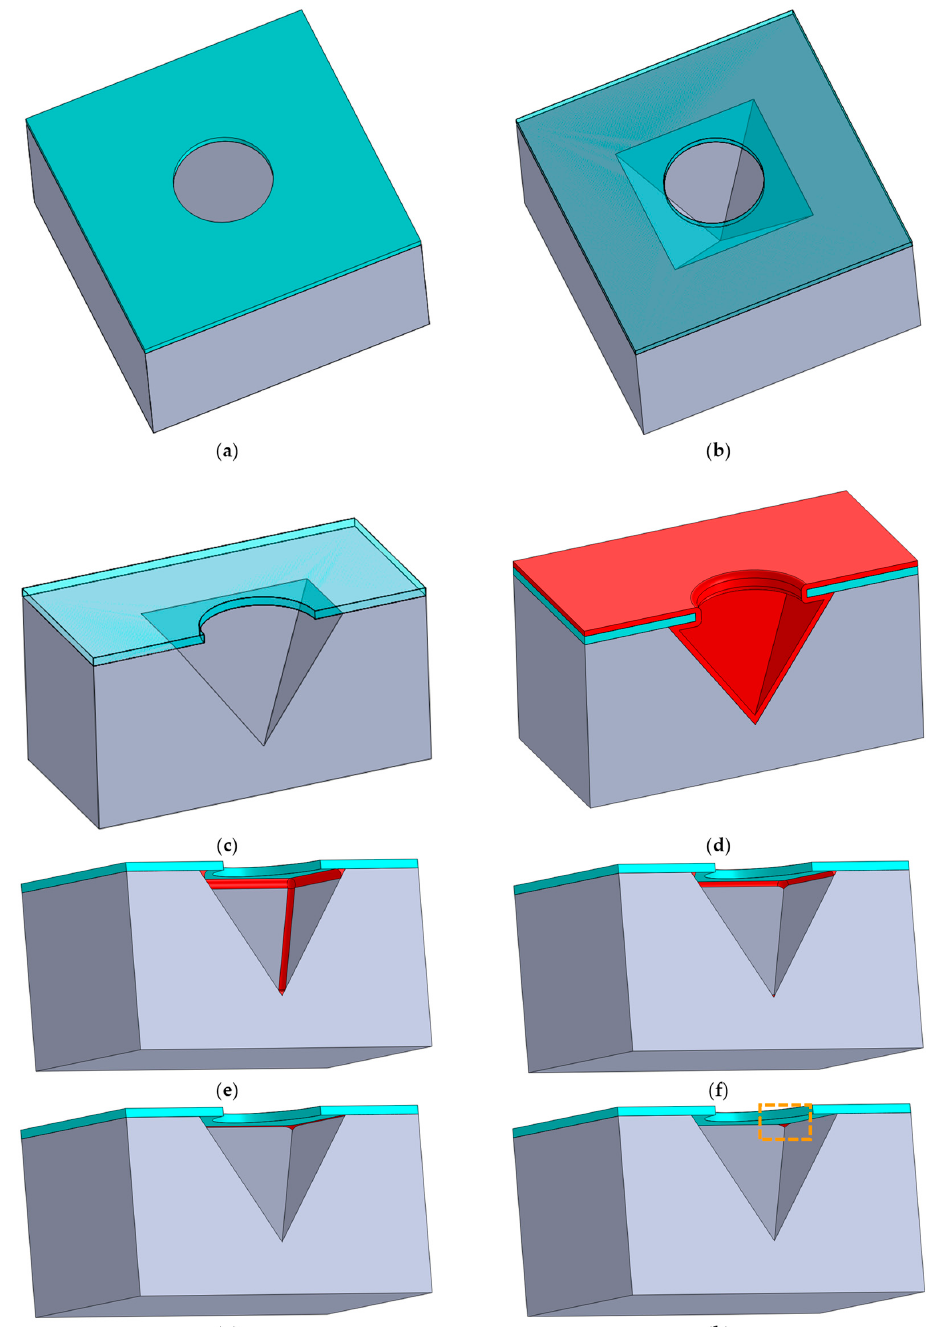
Figure 8. First part of the process flow demonstrating various levels of CL: ( a ) Si (grey) with SiO 2 hard-mask (blue) containing an etched hole. ( b ) Anisotropic etching of an inverted pyramid Si using KOH via the hole in the hard-mask. ( c – h ) Cross-sections. ( c ) Etched inverted pyramid. ( d ) Deposition of Si 4 N 4 (red) with a thickness t . ( e ) Etching of Si 3 N 4 with an etching distance of t or an EF of 1 leaving an Si 3 N 4 “wireframe”. ( f ) Etching of Si 3 N 4 with an EF of 1.35, leaving only a Si 3 N 4 “ring” at the base and a nanodot at the apex of the inverted pyramid. ( g ) Etching of Si 3 N 4 with an EF of 2, leaving only the Si 3 N 4 ring. ( h ) Etching of Si 3 N 4 with an EF of 2.2, leaving only nanodots at the vertices of the base of the pyramid. The dashed rectangle indicates the location of the zoom-in of Figure 9.